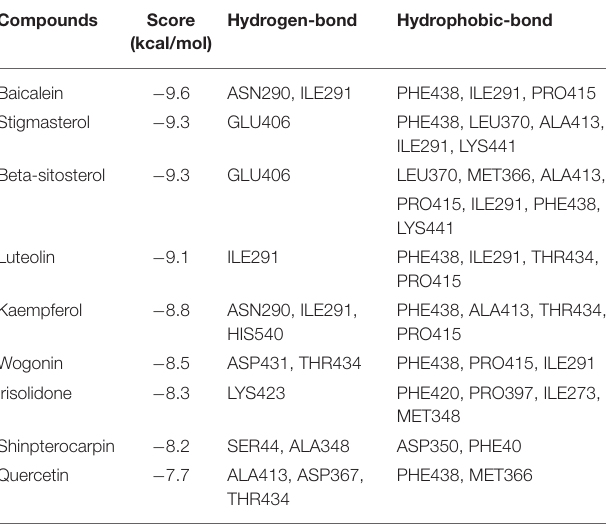
TABLE 6 | Binding free energy of nine compounds to